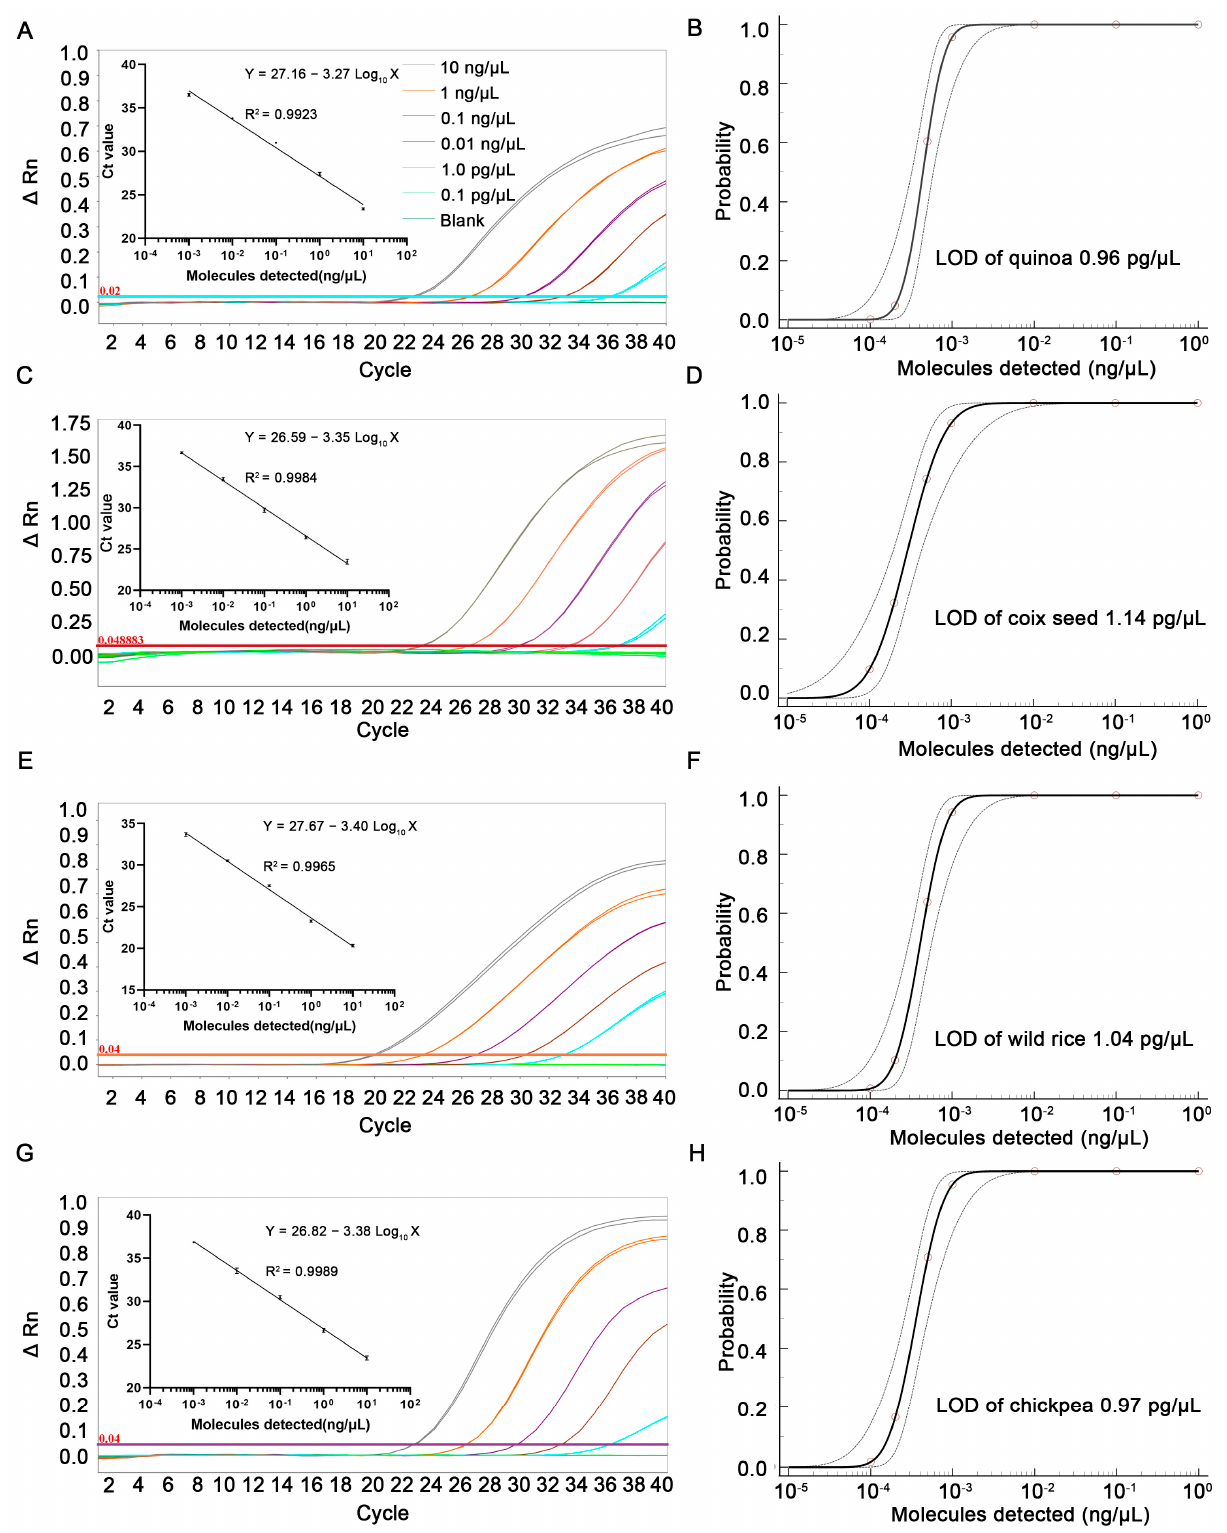
Figure 2. Amplification curves and standard curves for the analysis of 6 dilution steps of quinoa ( A ), coix seed ( C ), wild rice ( E ), chickpea ( G ) qPCR assay. Inner: standard curves and linear equation of quinoa ( A ), coix seed ( C ), wild rice ( E ) and chickpea ( G ), respectively. Probability regression curves of LOD of quinoa ( B ), coix seed ( D ), wild rice ( F ) and chickpea ( H ) by qPCR assay. Probabilistic